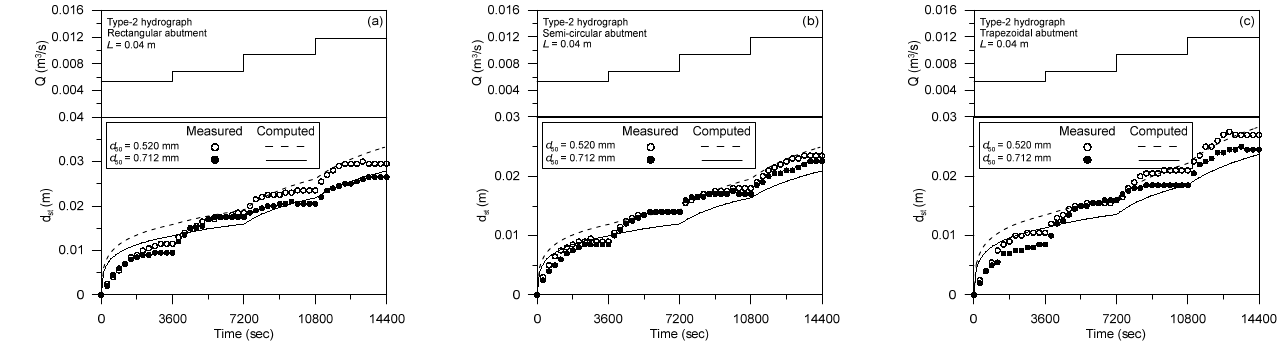
Figure 10. Comparison of computed and measured abutment-scour evolution under Type-II stepwise (symmetrical) hydrograph. ( a ) Rectangular abutment ( b ) Semicircular abutment ( c ) Trapezoidal abutment.